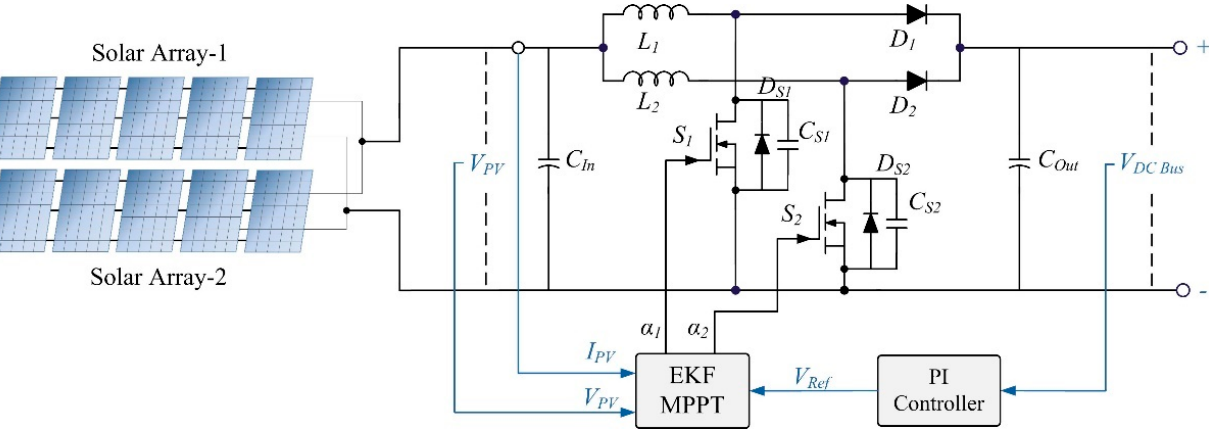
Figure 5. Schematic diagram of the simulation model for two − phase IBC with EKF MPPT controller. Thus, the state-space equations are obtained by combining four operation modes as